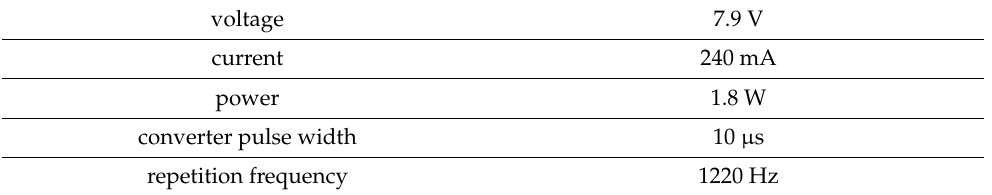
Table 1. Plasma ONE Dental. Technical Data (intensity level 5, DBD mode).